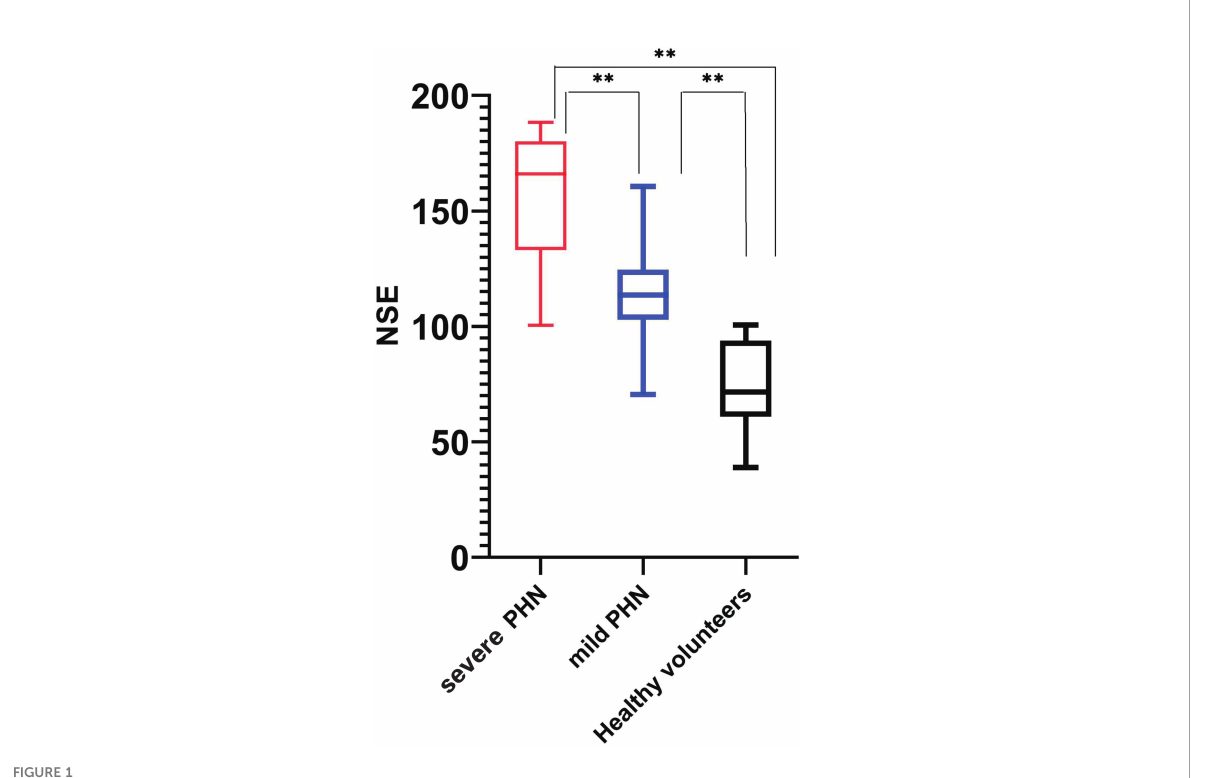
FIGURE 1 Serum NSE levels in all groups. ** means that the p-value is much less than 0.